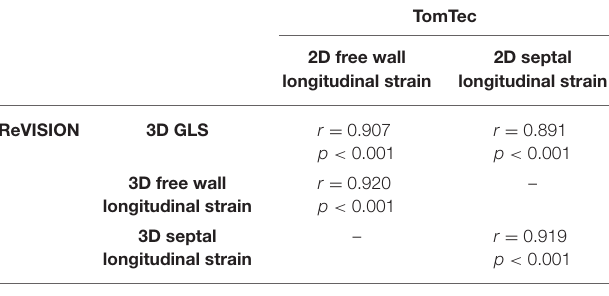
TABLE 3 | Correlations between the ReVISION- and TomTec-derived right ventricular strains ( n = 30).